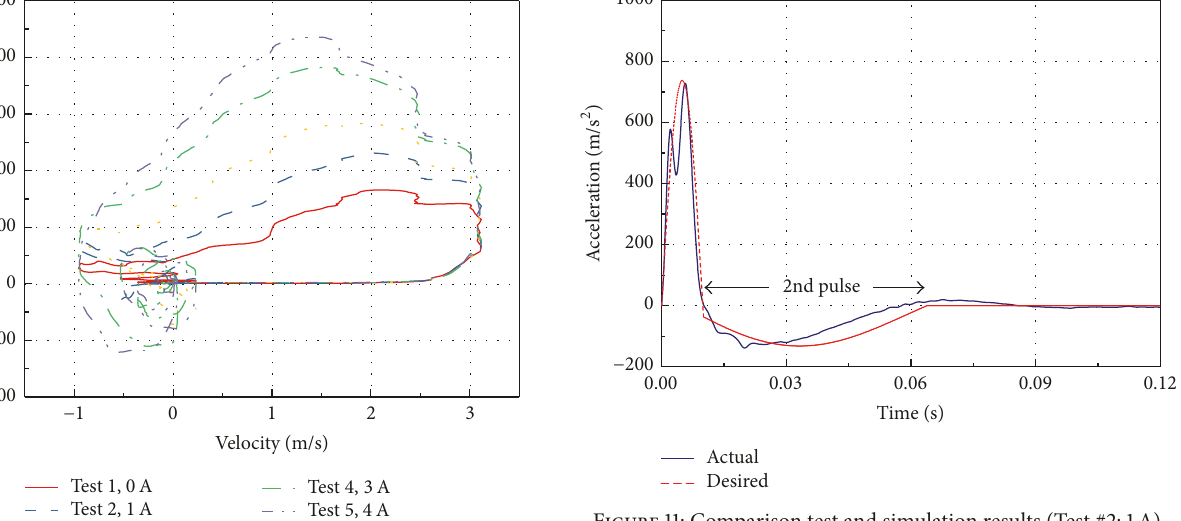
Figure 11: Comparison test and simulation results (Test #2: 1 A).